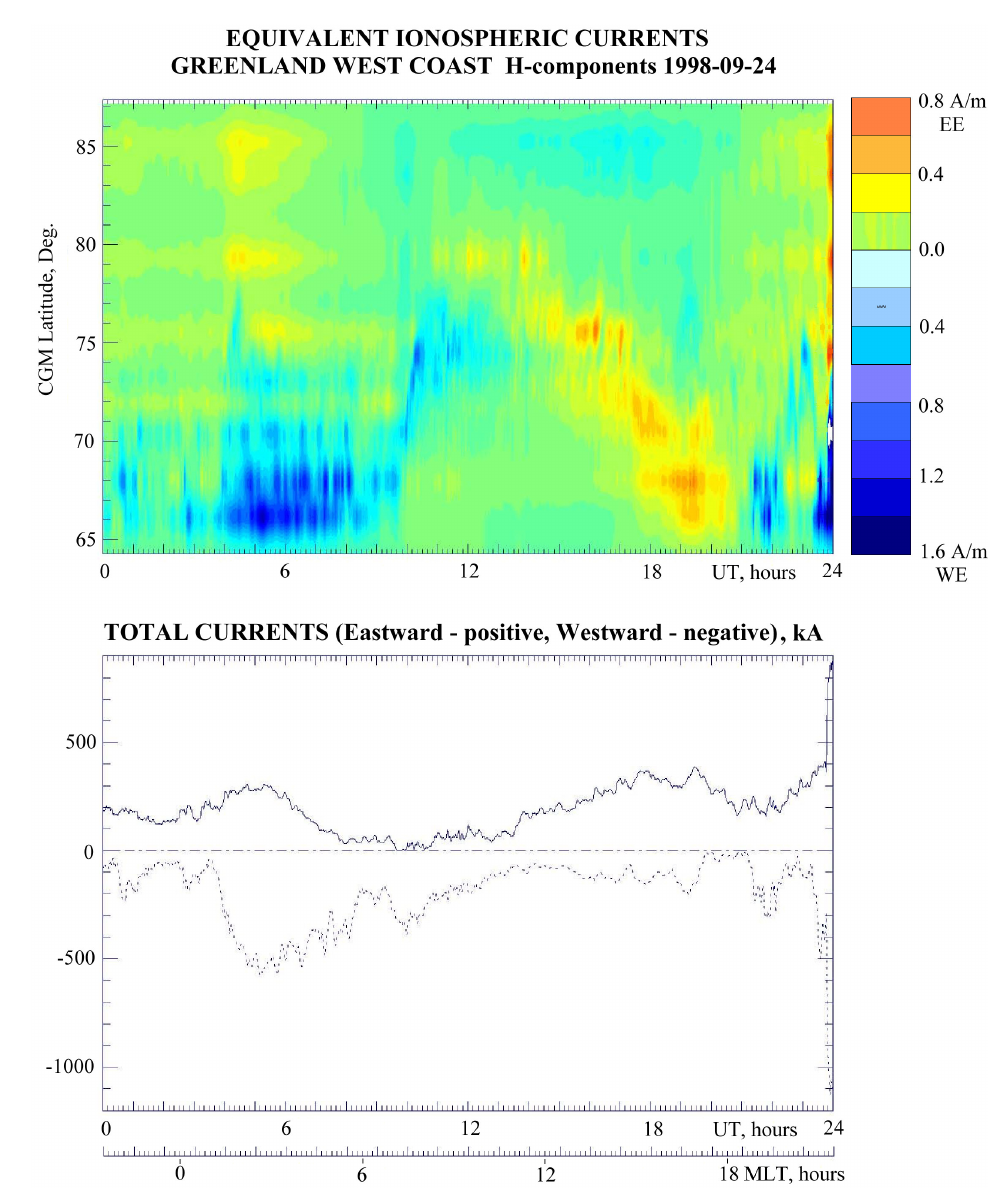
Fig. 2. The corrected geomagnetic latitude vs. UT plot of the eastward and westward equivalent ionospheric currents as calculated using H component data on 24 September 1998 from the GWC meridian chain of magnetic observatories (top panel). Total intensity of the eastward (above) and westward (below) currents according to the GWC chain H component (bottom